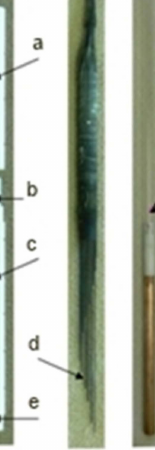
Figure 14. Sample and sample holder where ( a ) and ( c ) are the upper and lower alumina capsule, ( b ) is the sample, ( d ) is the thermocouples, ( e ) is the connection part of the lower alumina capsule to the copper cooling core ( g ), and ( f ) is the quartz tube.